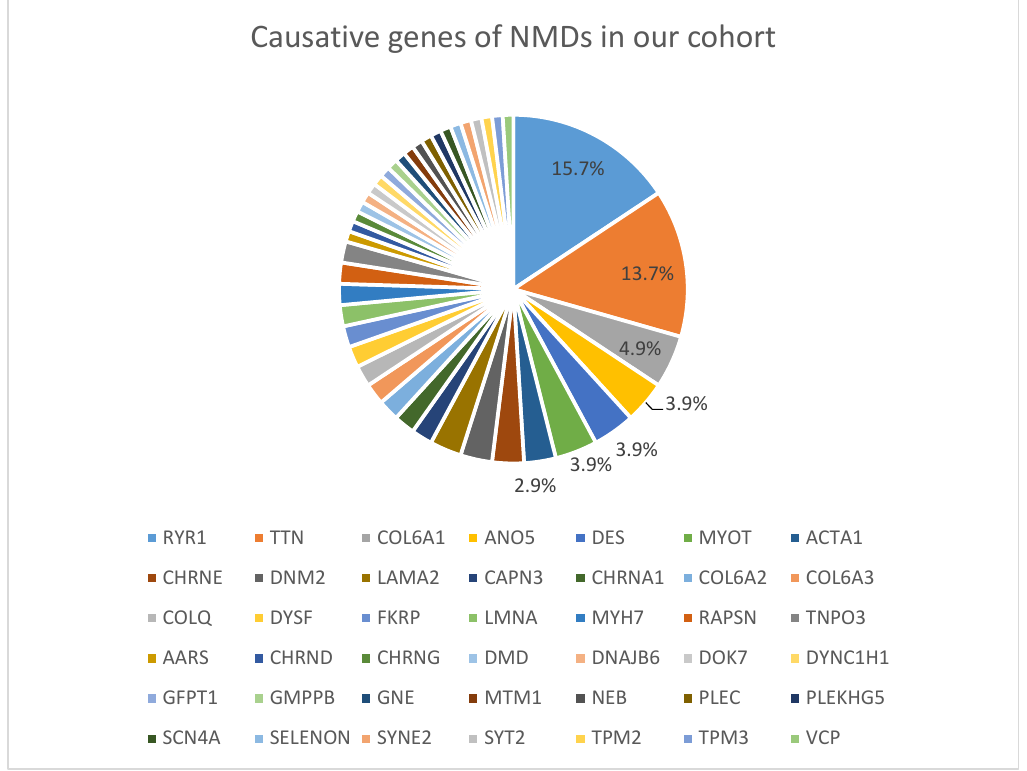
Figure 1. Causative genes of NMDs in our cohort. Percentages indicate the proportion of cases with the corresponding genetic defect among solved cases.